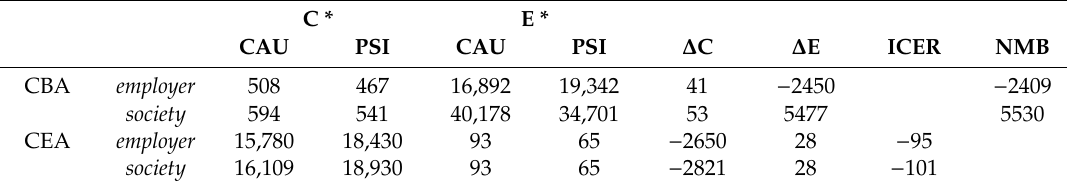
Table 5. Incremental Cost, E ff ect and ICERs for the Di ff erent Analyses, for Both Employer and Societal Perspective. All Numbers are Based on Bootstrap with 5000